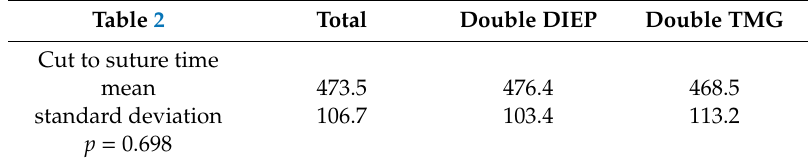
Table 2. Comparison of cut to suture time